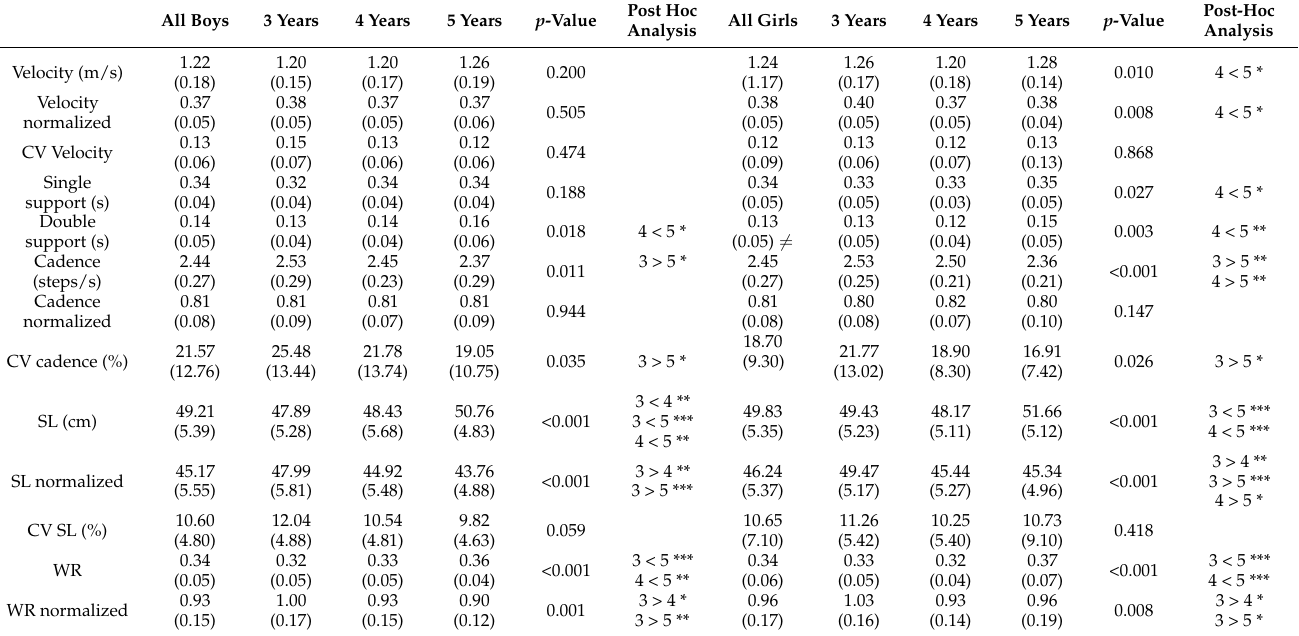
Table 1. Kinematic parameters of gait in relation to age and sex.